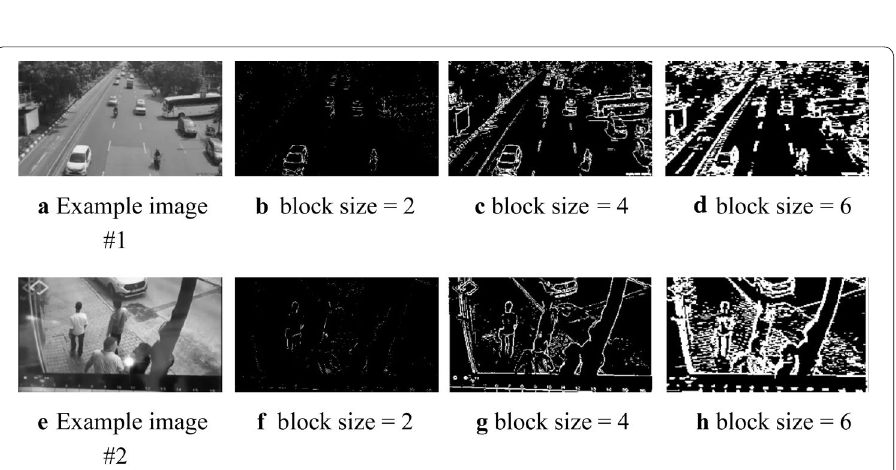
Fig. 5 The illustration of different block size used in the proposed texture